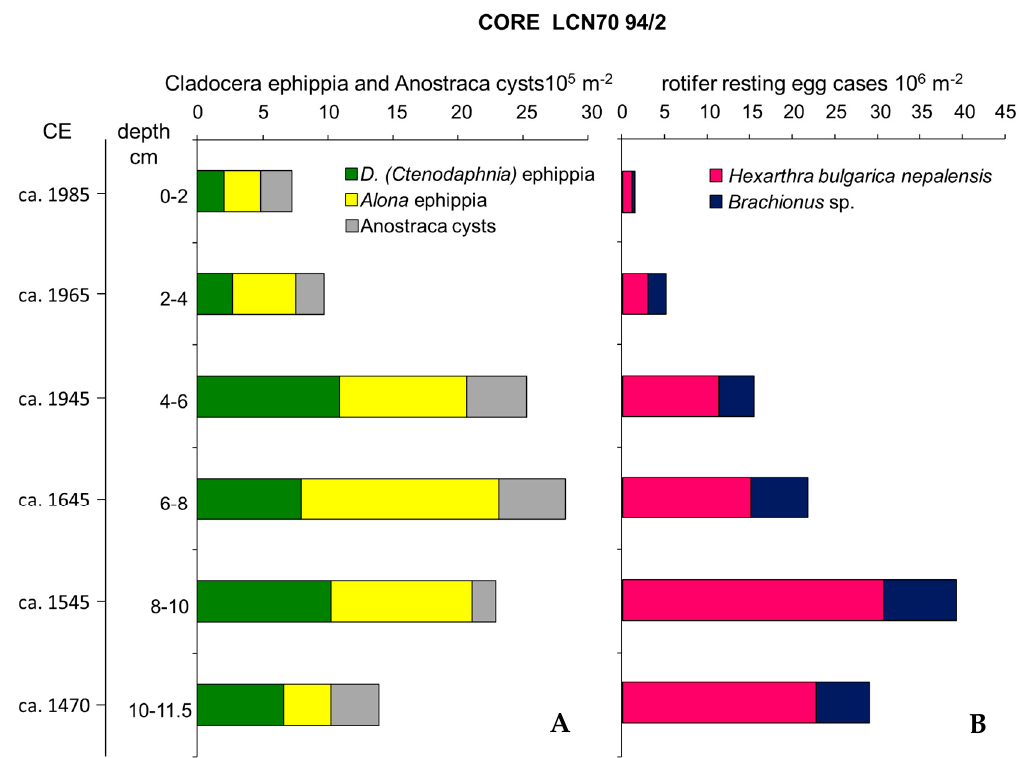
Figure 4. Abundance of Cladocera ephippia and Anostraca cysts ( A ) and rotifer resting eggs ( B ) recovered from sediment core LCN70 94/2.